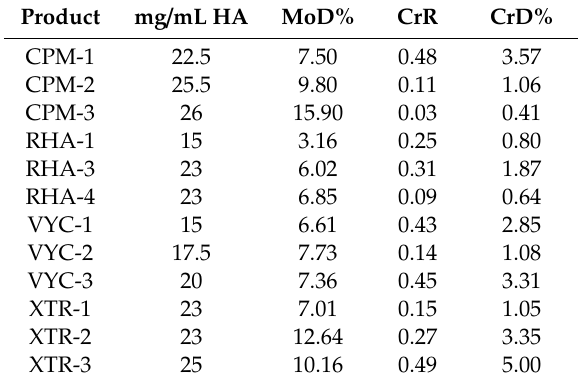
Table 3. Summary of crosslinking parameter measurements of the HA fillers evaluated.